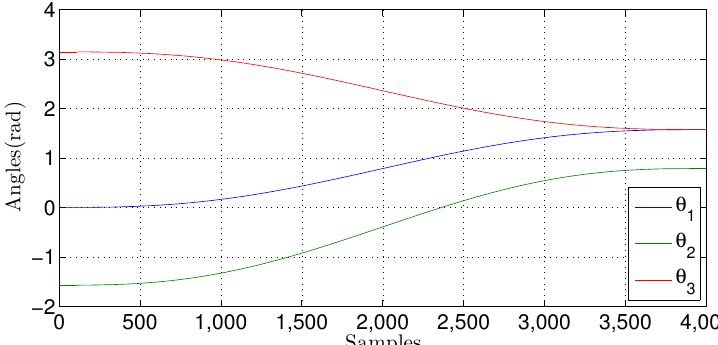
Figure 26. Trajectory of each rotatory joint of the Phantom Omni used to perform the